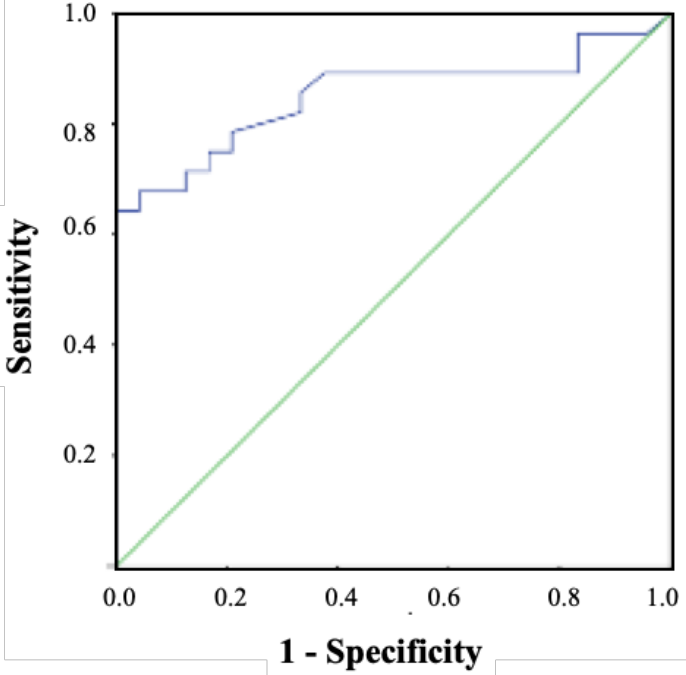
Figure 3. Receiver-operating characteristic (ROC)curve for mild cognitive impairment (MCI) prediction with CV sl (%) performance.